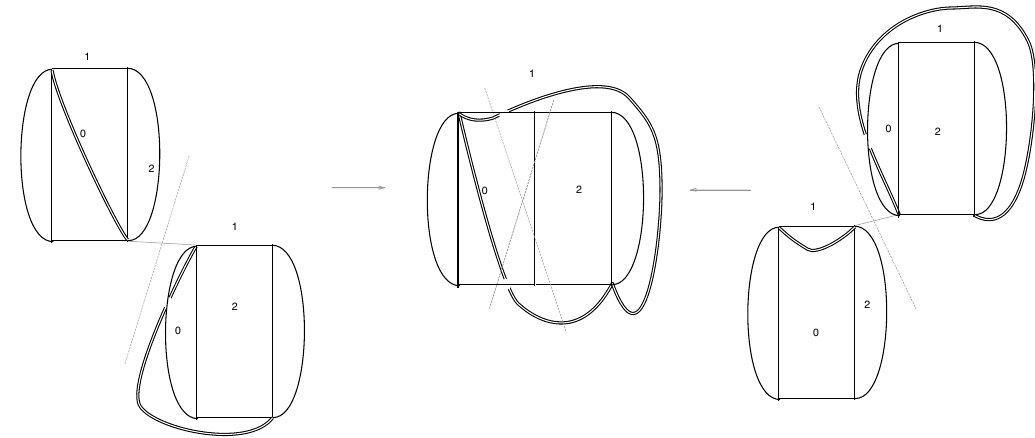
Figure 42 . A comparison of U f U f and U f U f for edges e , e 0 adjacent to the same face f . Left e e e 0 e 0 and Right: the corresponding pairs of pillowcase geometries. Middle: the fused geometry. If the edges e and e 0 are the 01 and 12 edges of f , the center lines emanating from the fused junctions at f reconnect as shown in the middle. The two center lines can be identi(cid:12)es only up to a change of one unit of framing. Similar pictures with the outer face labelled by 0 or 2 match with no change of framing. Hence associativity fails only if e and e 0 are the 01 and 12 edges or vice-versa.